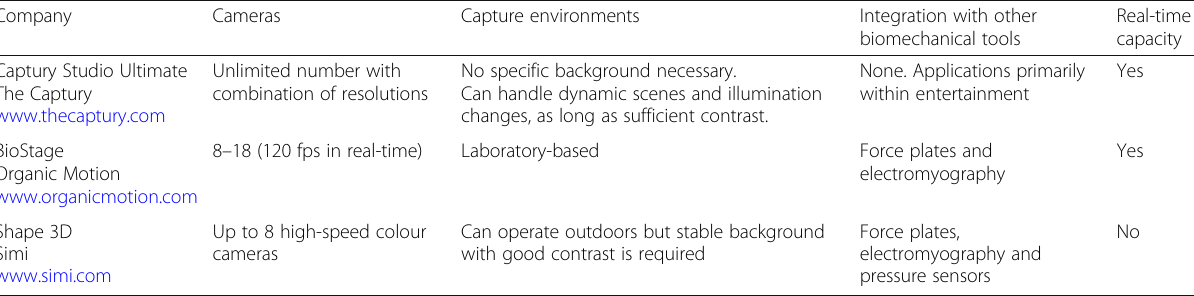
Table 1 A selection of commercially available full-body markerless systems Company